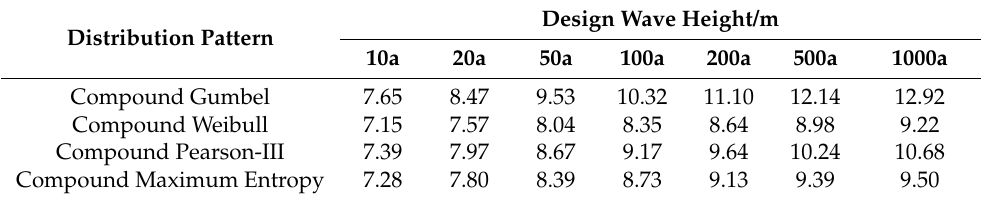
Table 6. Design wave height of traditional one-dimensional compound extreme value